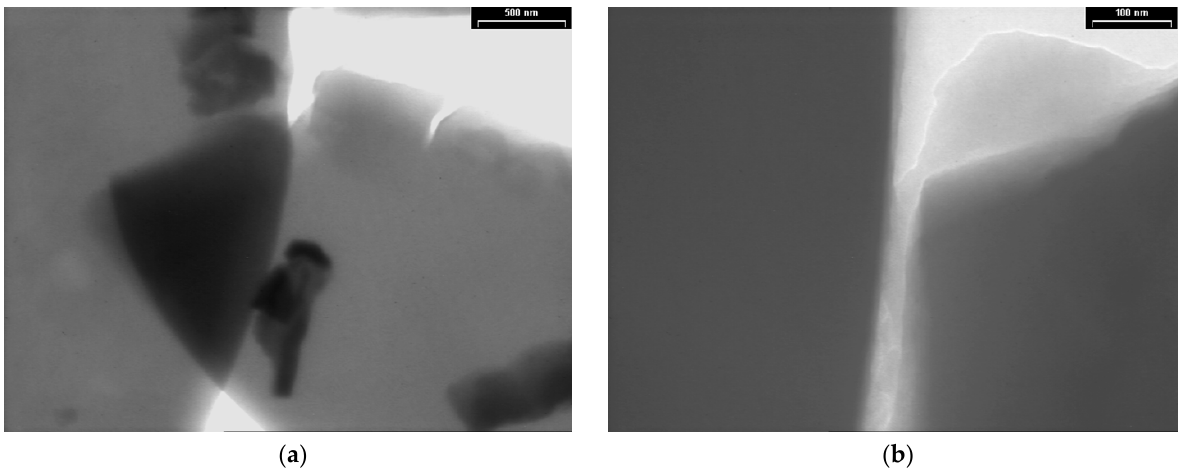
Figure 4. TEM images of PPAni thin films at various magnifications, with scale bars ( a ) 500 nm; ( b ) 100 nm.